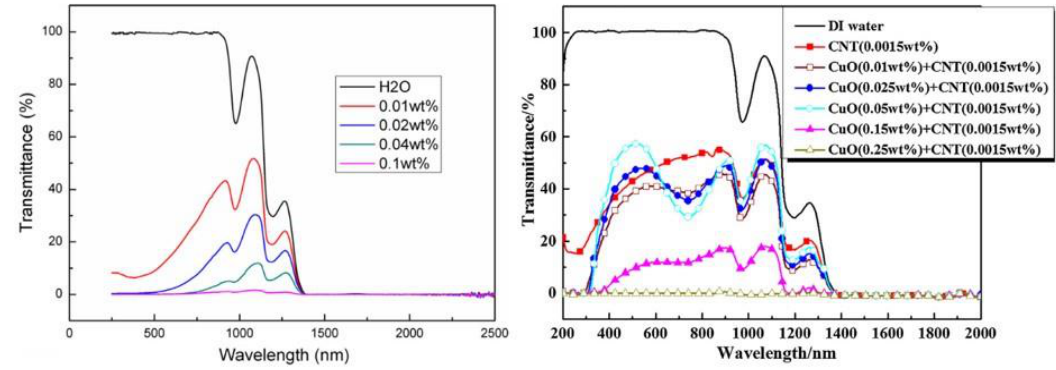
Figure 7. Diffuse reflection absorbance of CuO nanofluid [48]; 2017, RSC.